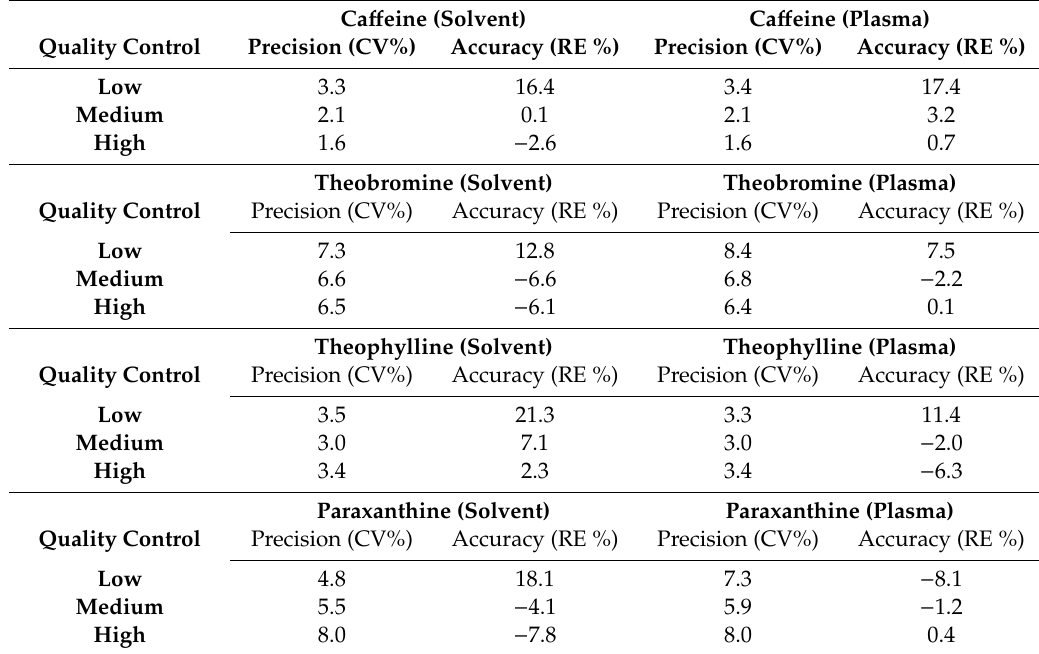
Table 2. Inter-day precision and accuracy for ca ff eine, theobromine, theophylline, and paraxanthine determined in calibration curves prepared in solvent and plasma. Results for the precision study are expressed as the % of the coe ffi cient of variation (CV) and for accuracy as the % of the relative error (RE). Ca ff eine